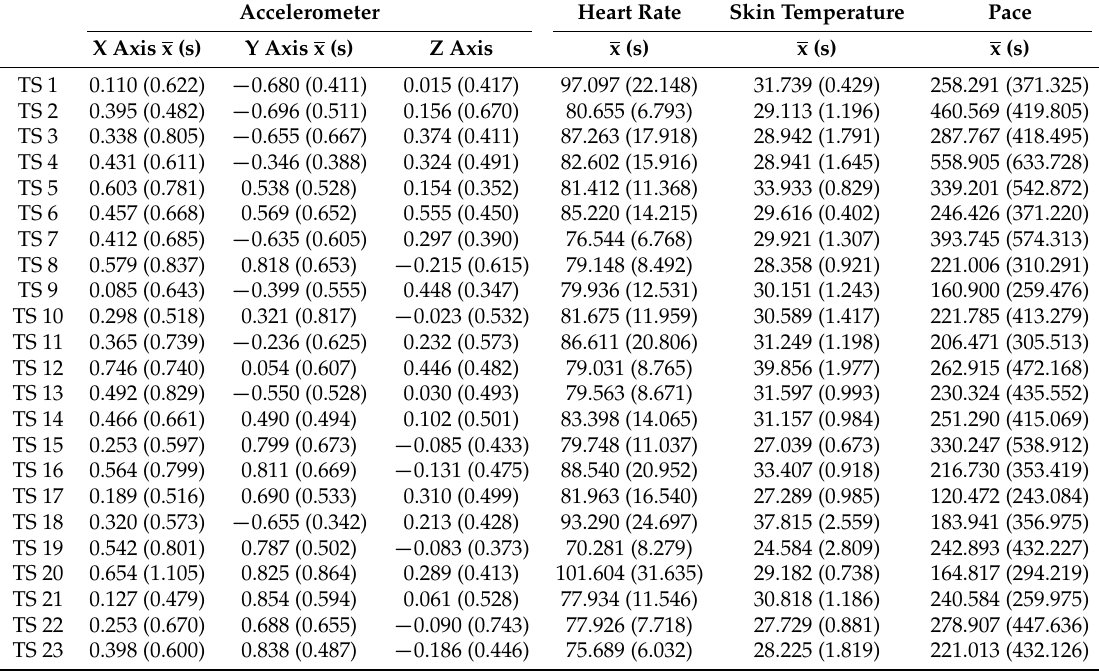
Table A5. Anomaly conditions dataset. Part II.